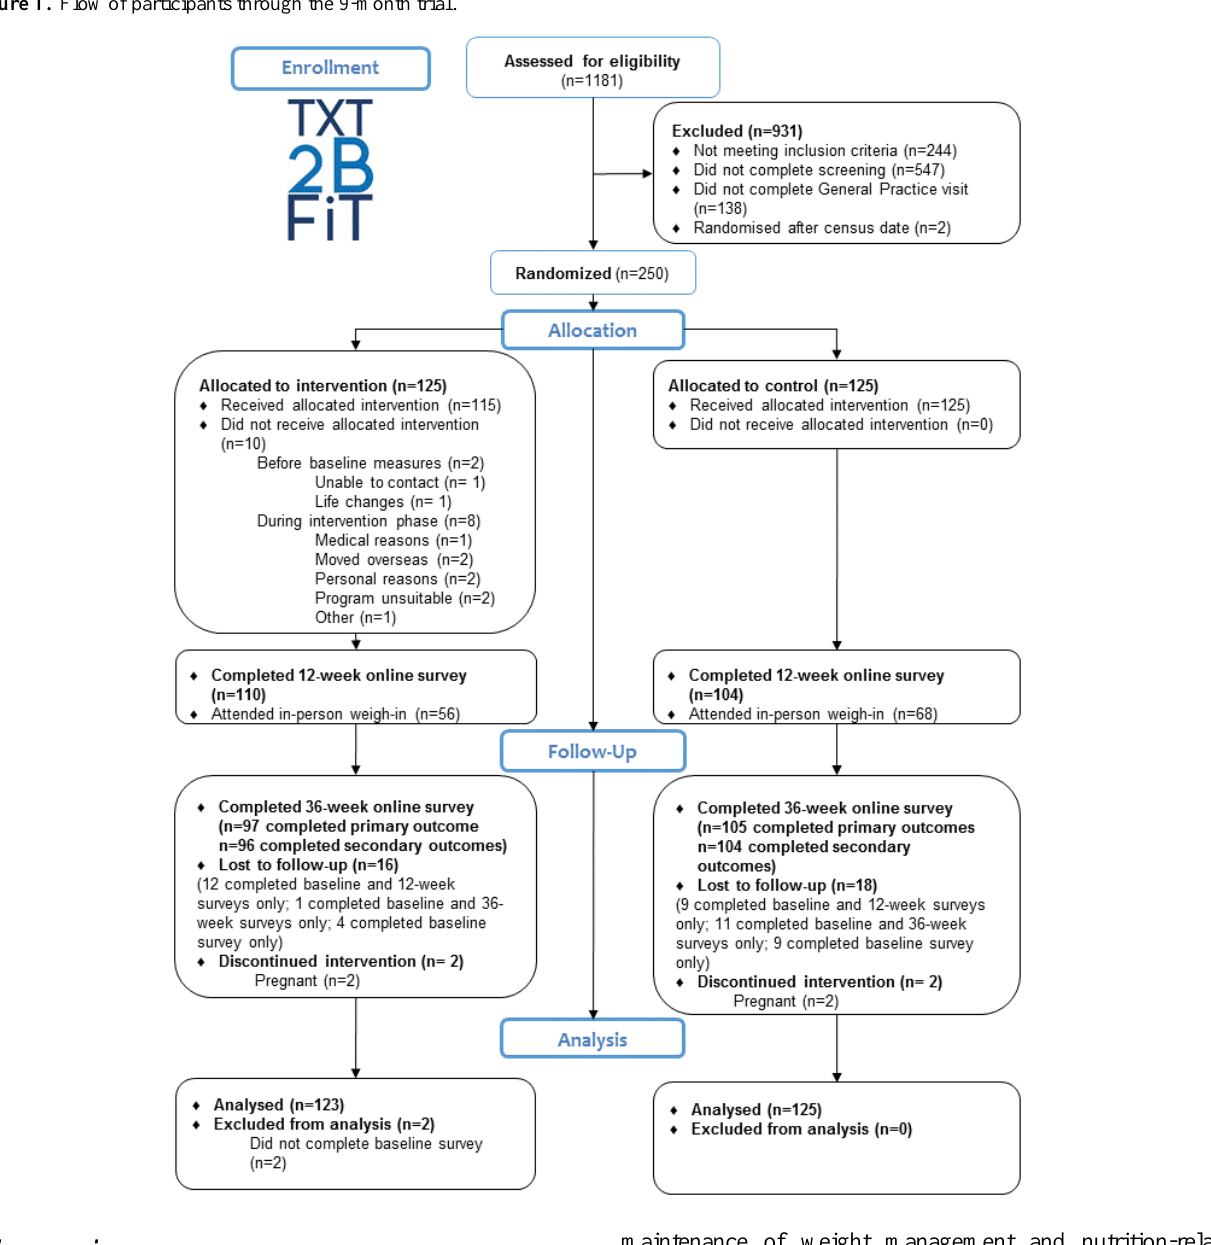
Figure 1. Flow of participants through the 9-month